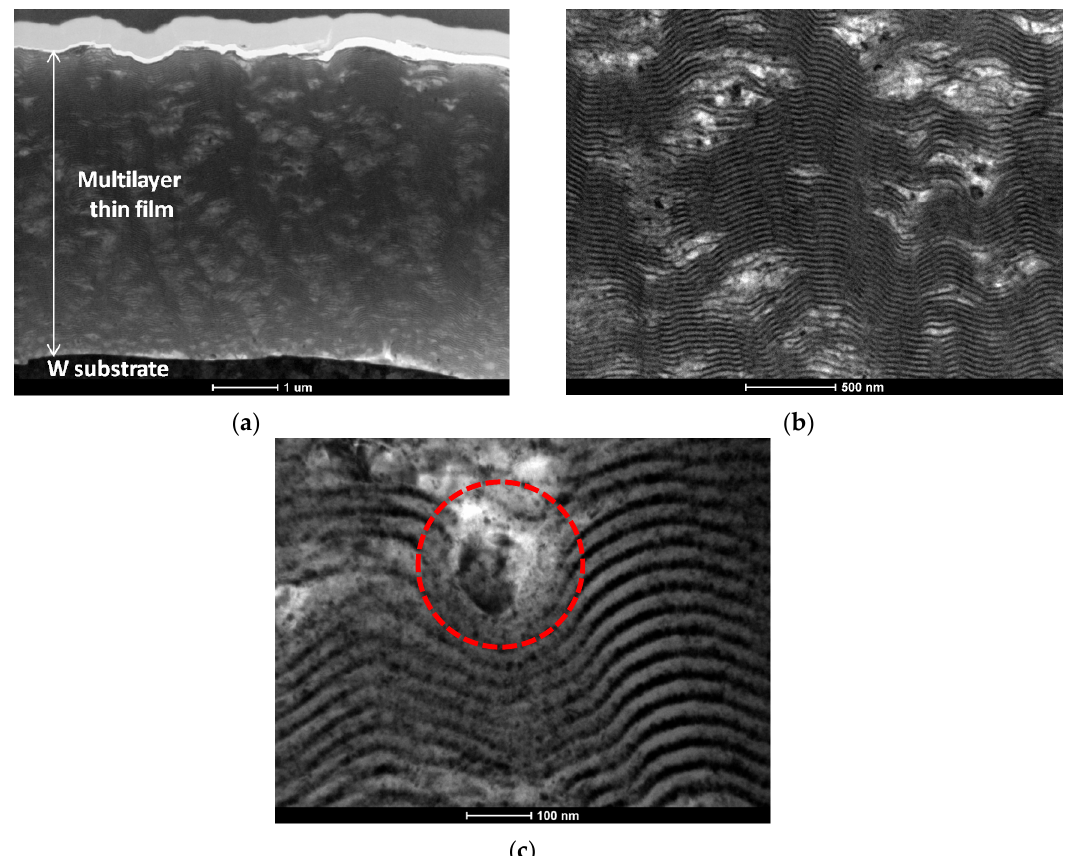
Figure 3. BF TEM micrographs of a Ni/Al multilayer thin film deposited onto W wire. ( a – c ) Correspond to images at increasing magnifications. The red circle in the highest-magnification image corresponds to the region from which the SAD pattern in Figure 6 was obtained.